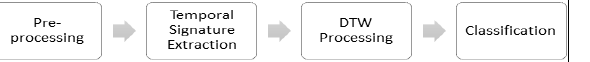
Figure 3. General Classification Workflow